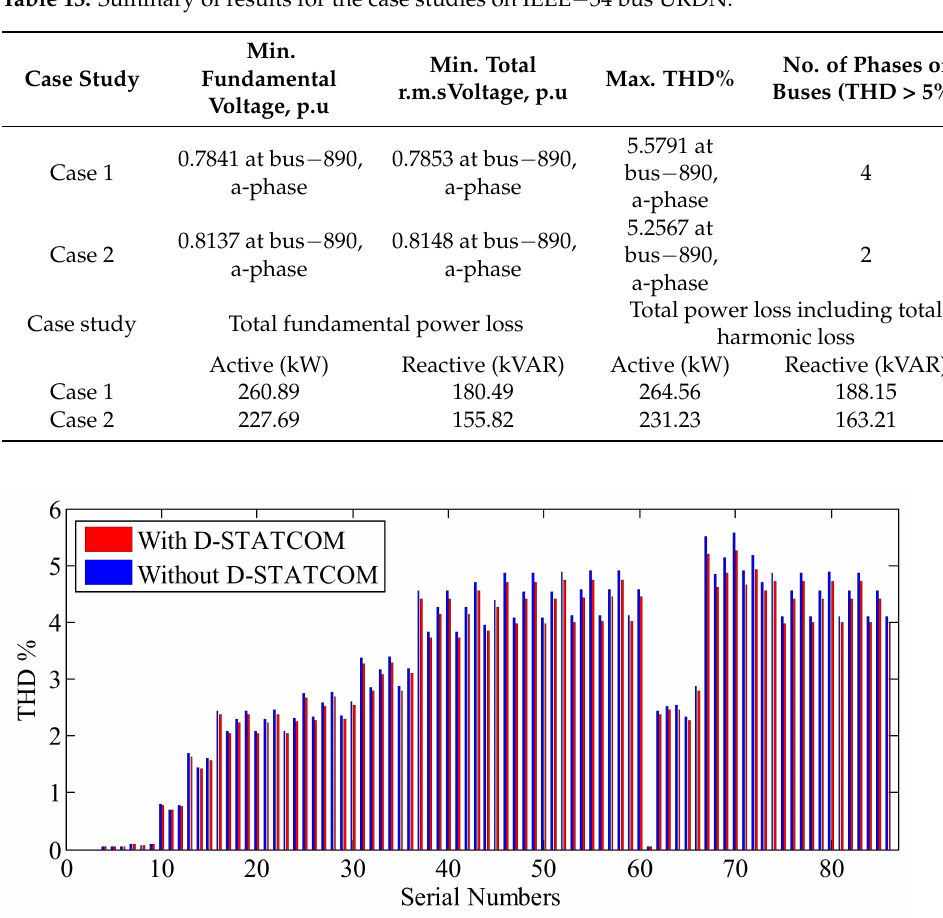
Figure 10. Comparison of THD% for case studies on IEEE − 34 URDN.